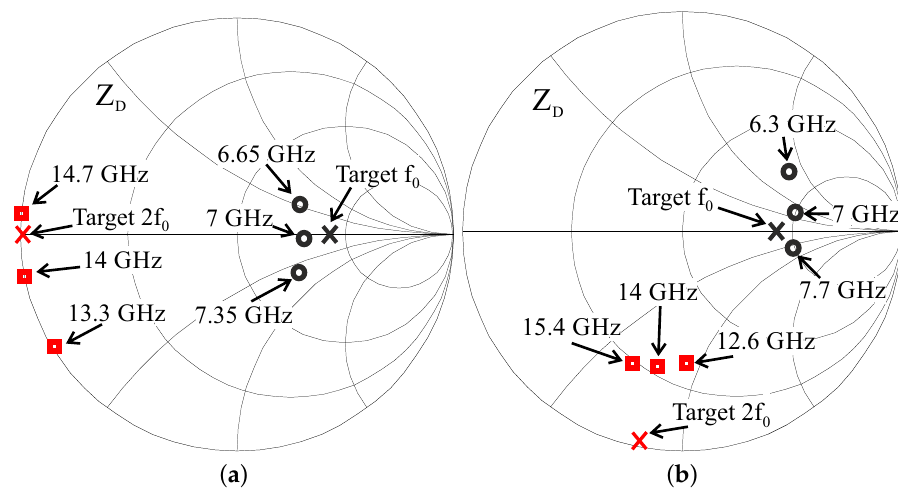
Figure 3. Optimum fundamental (black cross) and second harmonic (red cross) loads for the 8 × 75 µ m device, for Tuned Load ( a ) and Harmonic Tuned ( b ) designs. Synthesized loads at fundamental (black circles) and correspondent second harmonic (red squares) in a 10% bandwidth for the Tuned Load case, and in a 20% bandwidth for the Harmonic Tuned case.